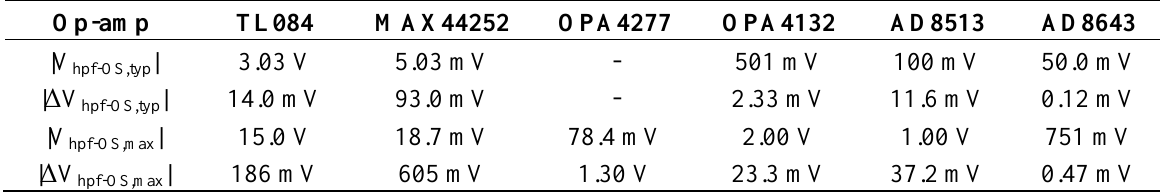
Table 7. Output DC offset estimated from the manufacturer specifications. Values obtained at the output v for the HPF in Figure 3. o